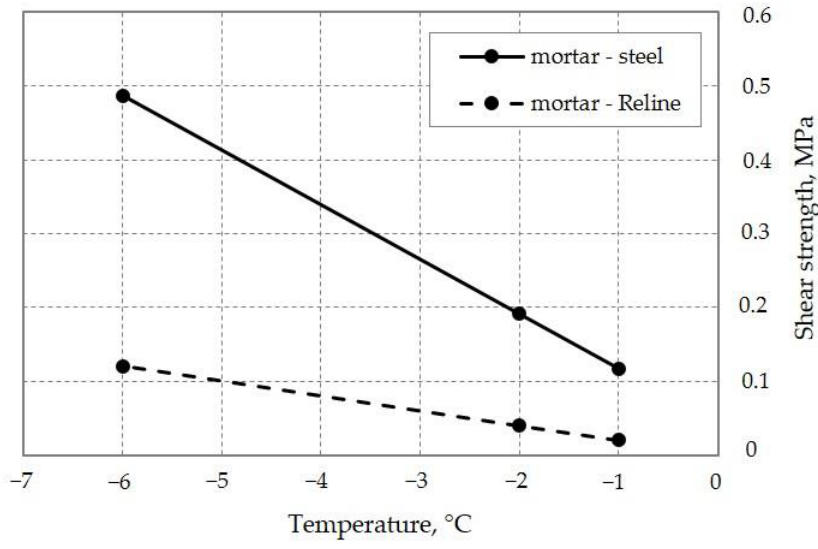
Figure 9. Temperature dependence of shear strength: mortar-steel and mortar- Reline . Table 4. Reduction (%) of frost heave uplift forces under increasing